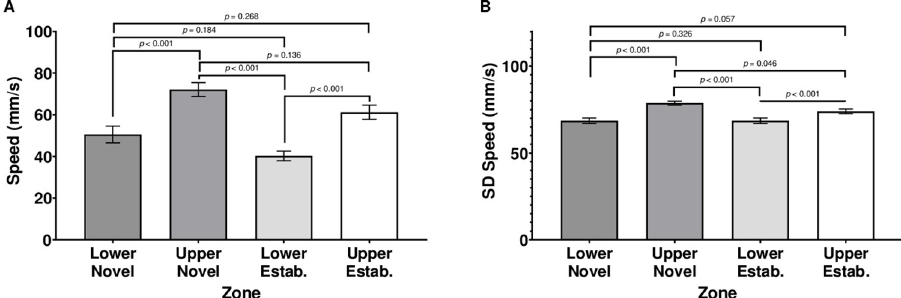
Fig 5. Average velocity (A) and velocity SD (B) during movement. Quadrants of the subject tank were labeled by upper/lower sections of the tank and novel/established stimulus shoal proximity. Error bars are +/- SEM . While exact p- values are reported for post-hoc comparisons, p- values smaller than 0.001 are indicated as p <